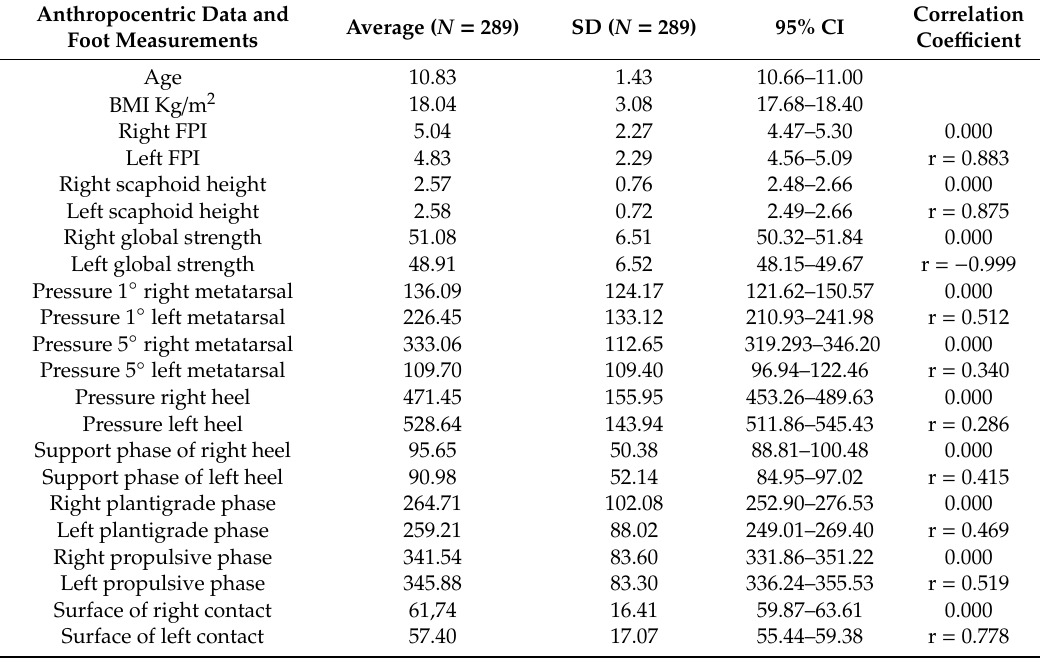
Table 1. Participants descriptive characteristics and anthropocentric data and foot measurements ( N = 289).